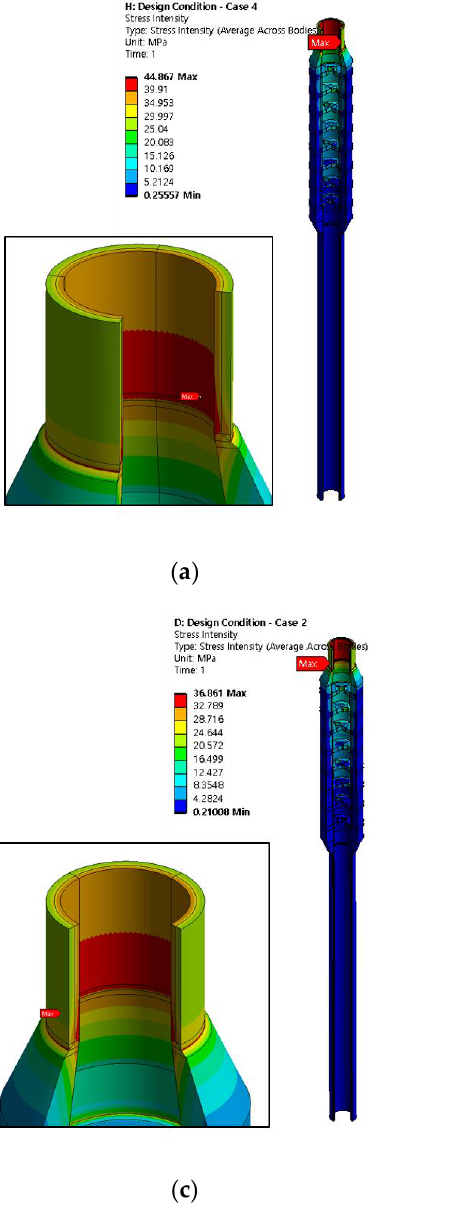
Figure 22. Distribution of stress intensity in the multi-stage orifice and the connecting pipes depending on the size of the hole diameter (d 8 ) in the eighth orifice stage: ( a ) d 8 /d = 0.84; ( b ) d 8 /d = 1.0 (original case); ( c ) d 8 /d = 1.24; and ( d ) d 8 /d = 1.49. Table 8. The predicted results of stress components depending on the size of the hole diameter (d 8 ) in the eighth orifice